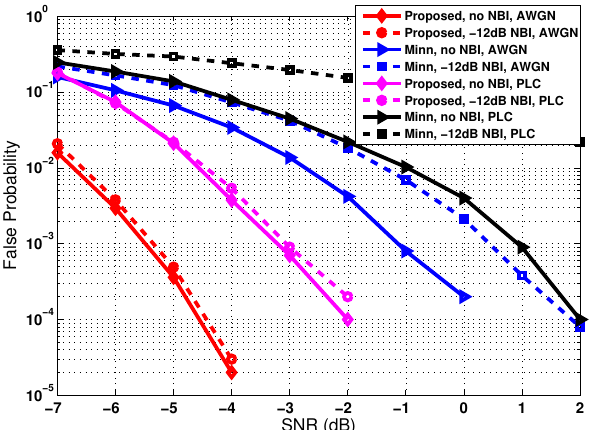
Figure 6. False probability of preamble detection in AWGN and PLC channels when the missed probability is around 10 − 3